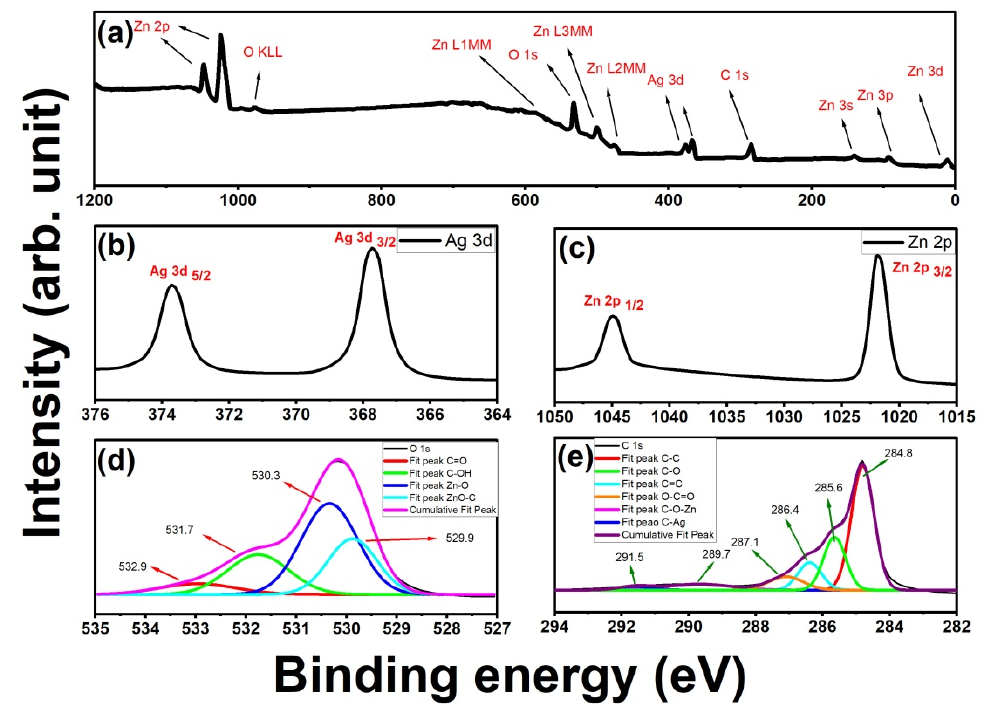
Figure 3. ( a ) A survey scan of XPS patterns of Ag-doped ZnO/MWCNTs nanocomposite and its HR spectra of ( b ) Ag 3d, ( c ) Zn 2p, (d) O 1s, ( e ) O 1s, and ( f ) C 1S. Figure 4 is the image of the SEM morphological analysis and elemental analysis of MWCNTs, ZnO/MWCNTs nanocomposite, and Ag-doped ZnO/MWCNTs. It shows that